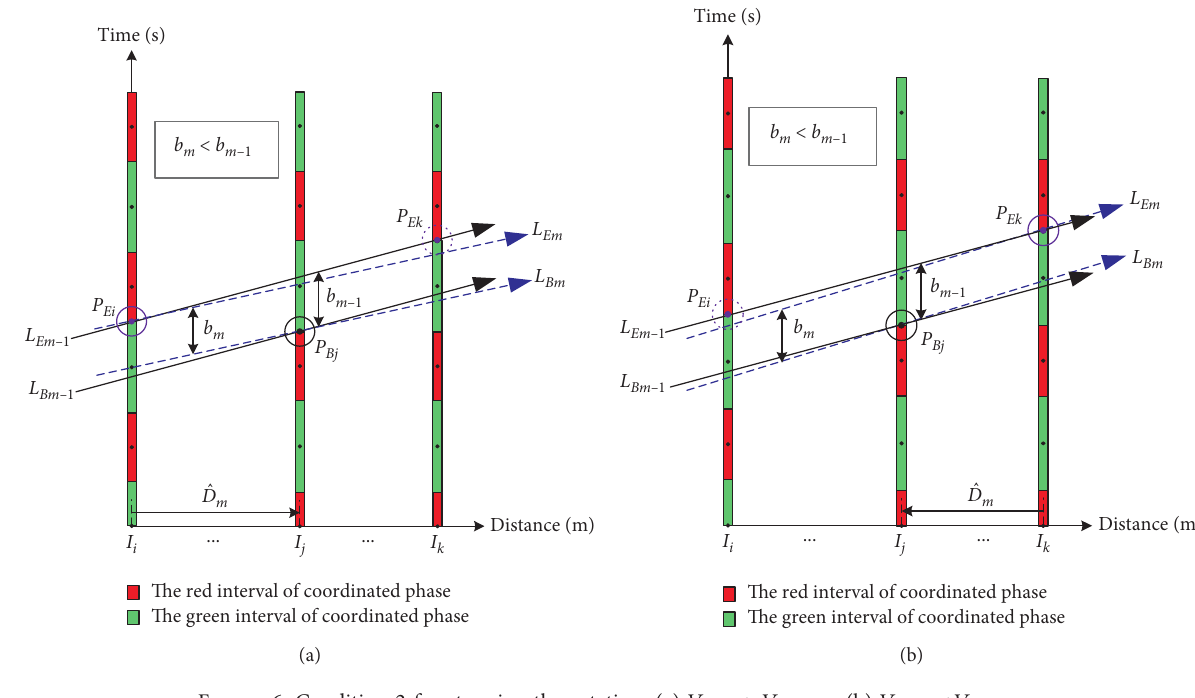
V V V ( 2 ,m ) > ( 2 ,m − 1 ) . (b) ( 2 ,m ) < ( 2 ,m − 1 ) .